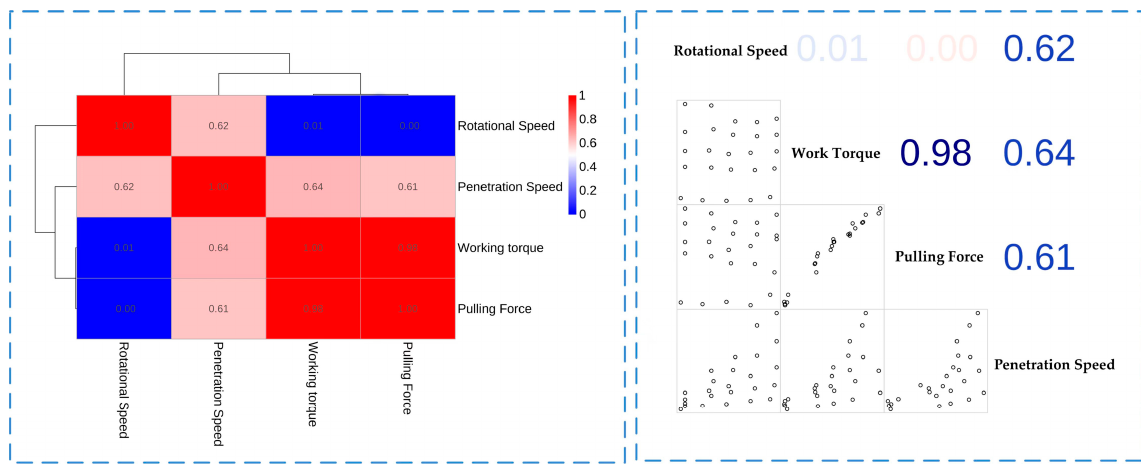
Figure 4. Correlation analysis diagram of the drilling parameters.